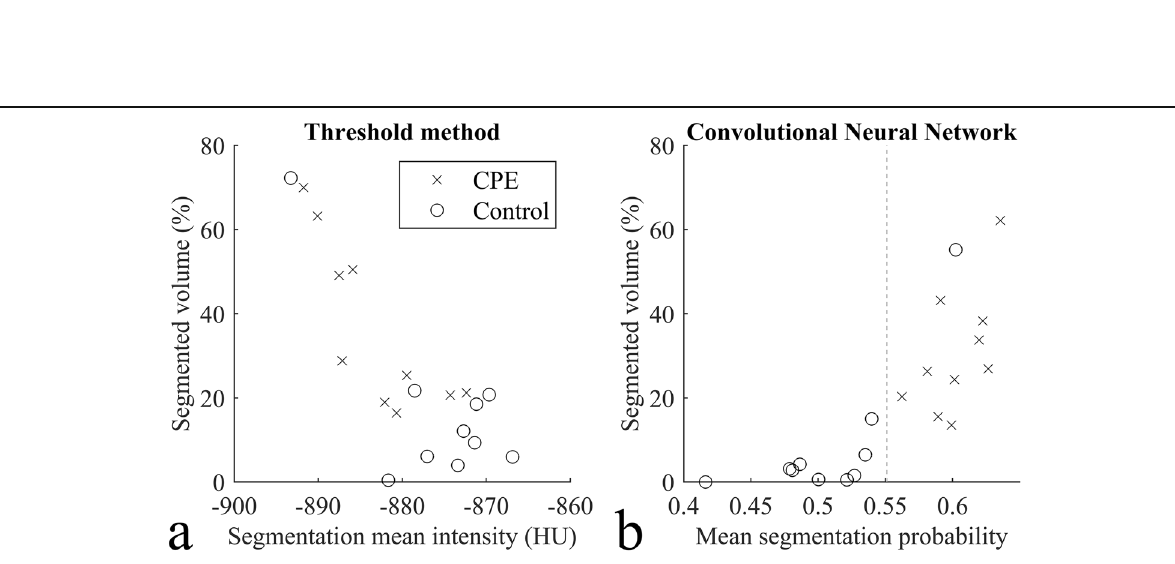
Fig. 6 CPE cases (test set cases of group A) are indicated with crosses and the controls (test set cases of group B) with circles. CPE Chronic pulmonary embolism, HU Hounsfield